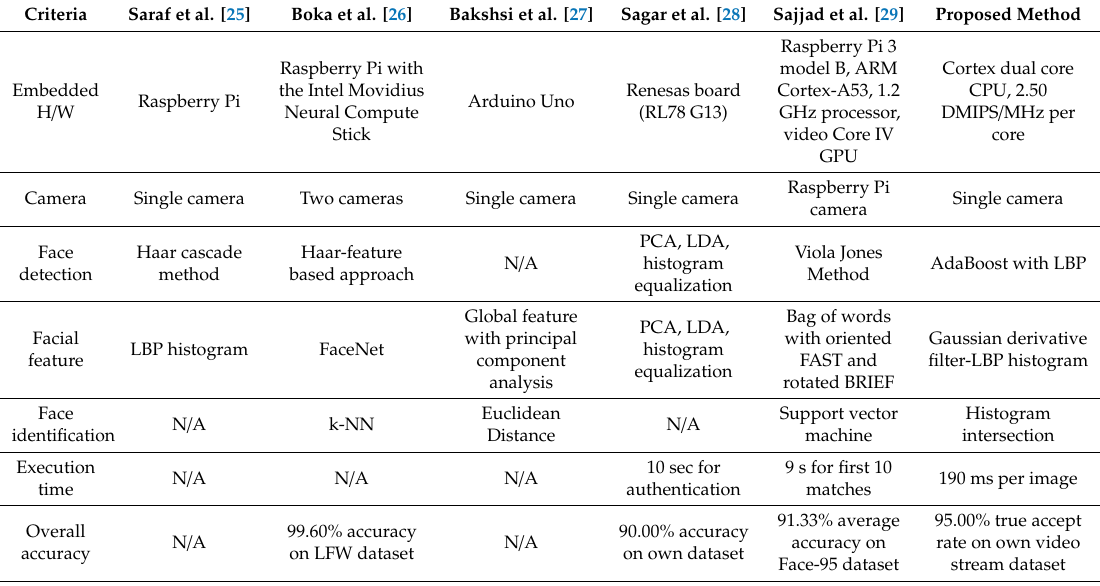
Table 5. Comparison with the stand-alone access control systems based on facial image